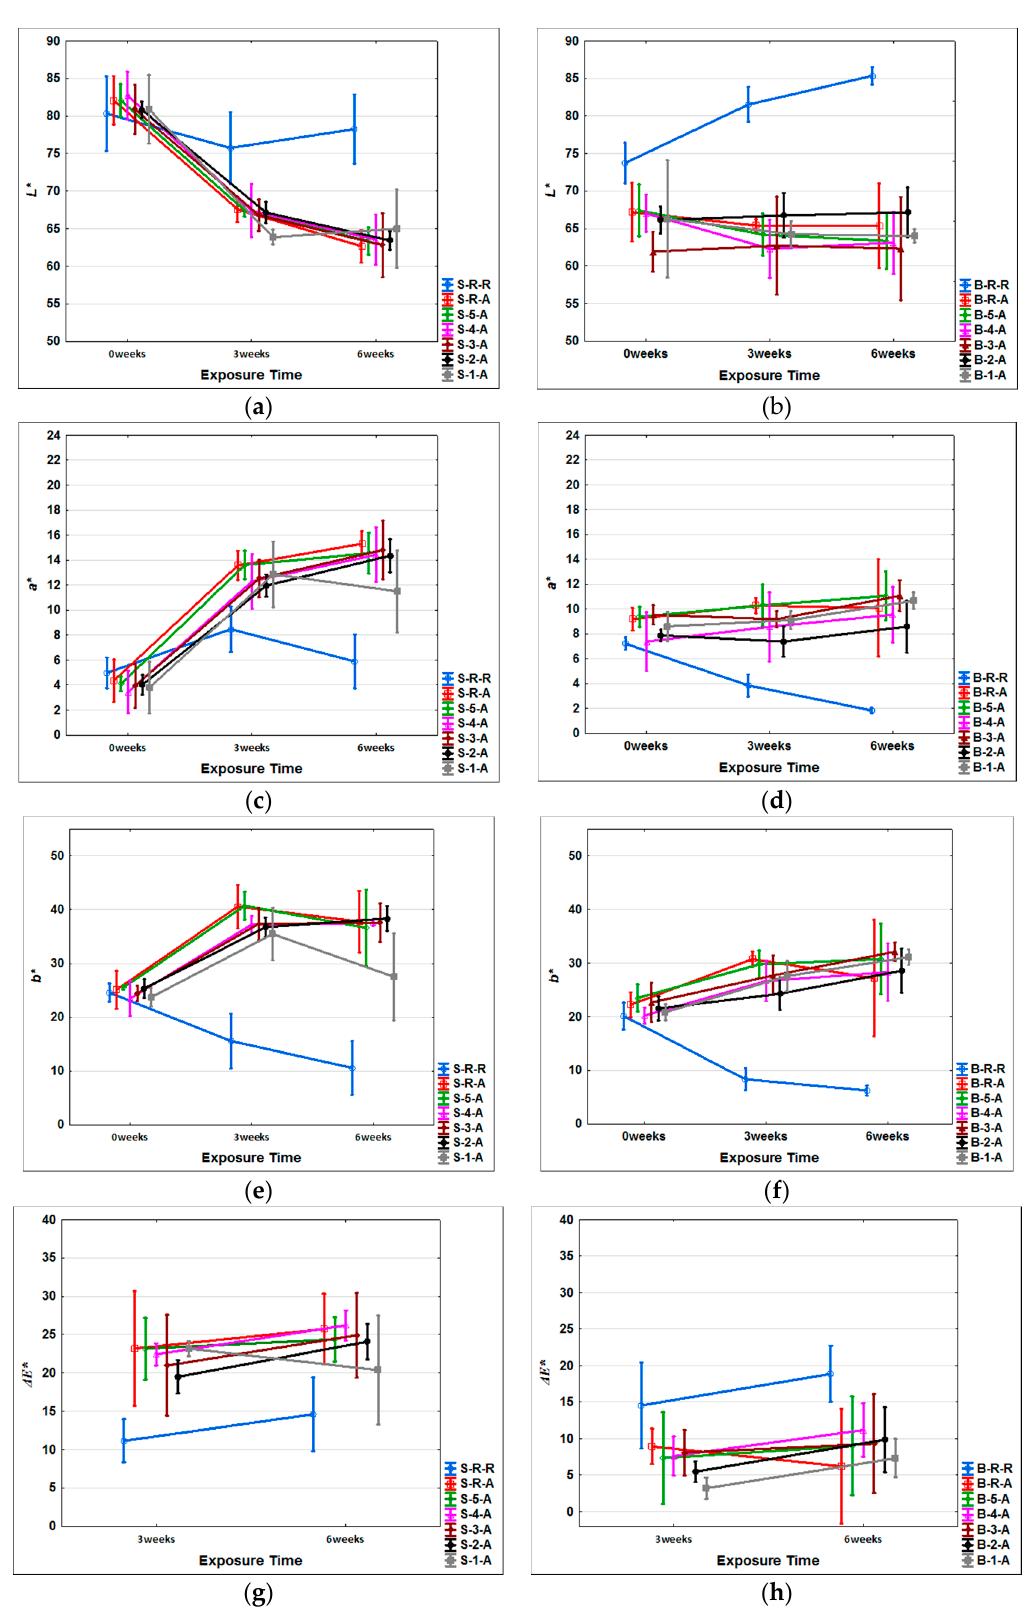
Figure 3. Colour changes in tested wooden surfaces during AW: ( a ) L * changes on spruce; ( b ) L * changes on beech; ( c ) a * changes on spruce; ( d ) a * changes on beech; ( e ) b * changes on spruce; ( f ) b * changes on beech; ( g ) Δ E * changes on spruce; ( h ) Δ E * changes on beech.